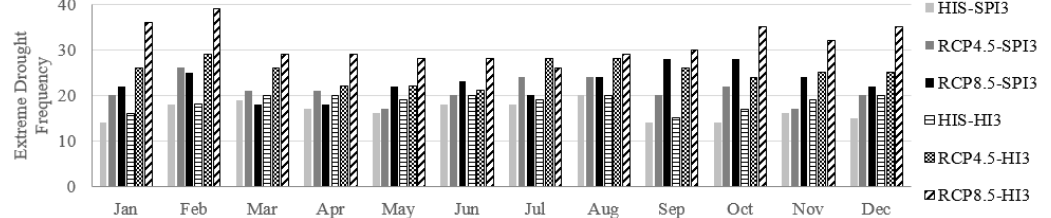
Figure 4. Monthly extreme drought frequency in the past and the future.